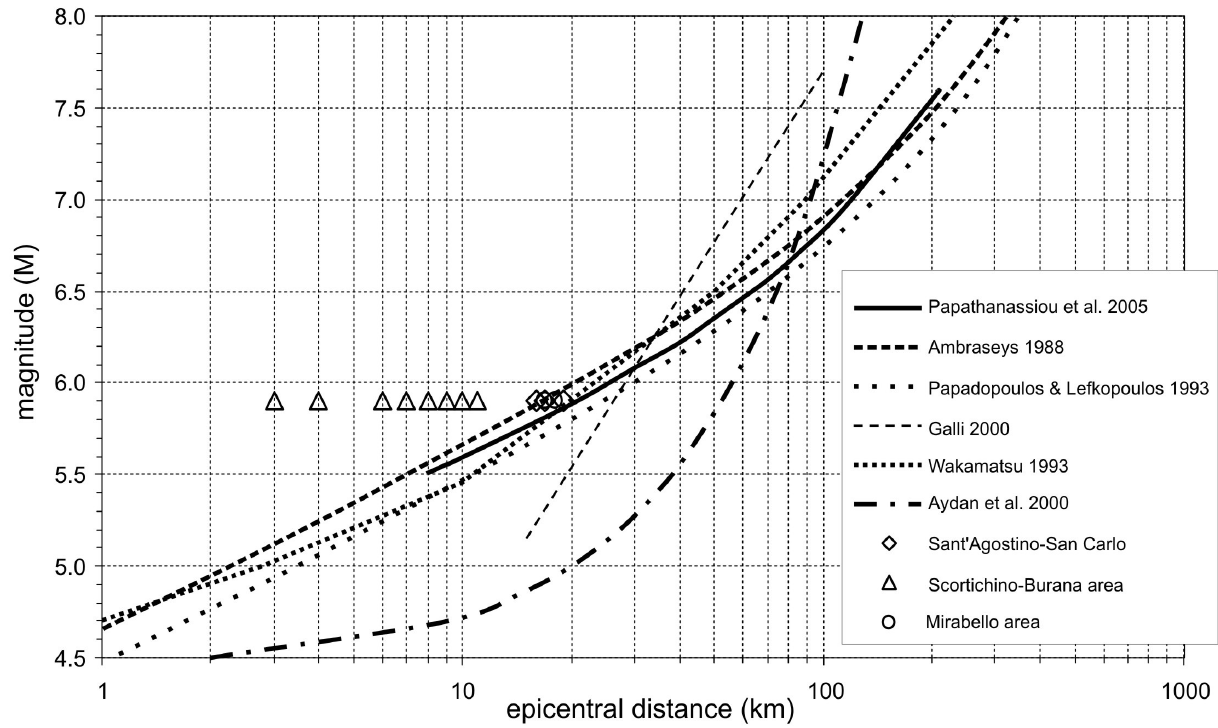
Figure 4. Distribution of the liquefied sites based on their epicentral distances and comparison with the triggering curves proposed by several studies for the assessment of liquefaction